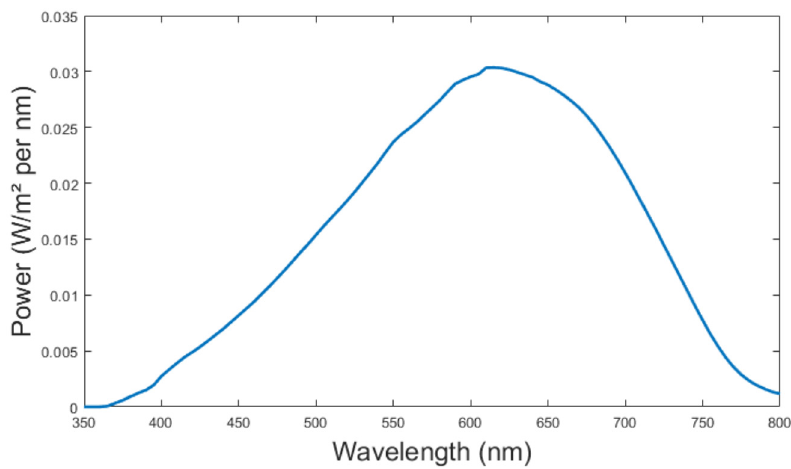
Figure 3. The spectral power distribution of the SCHOTT KL 1500 as a function of the wavelength.